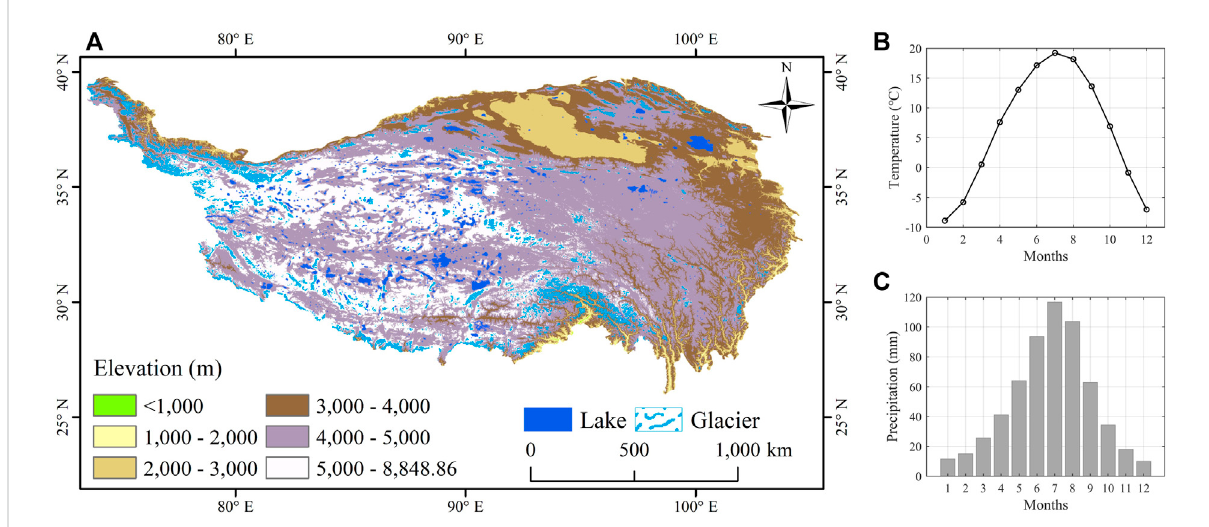
FIGURE 1 Study area (A) , boundary data for the Tibetan Plateau provided by the Global Change Science Research Data Publishing System (http://www. geodoi.ac.cn/WebCn/doi.aspx?Id=135), glacier vector data from the National Center for Glacial Permafrost Desert Science and Data